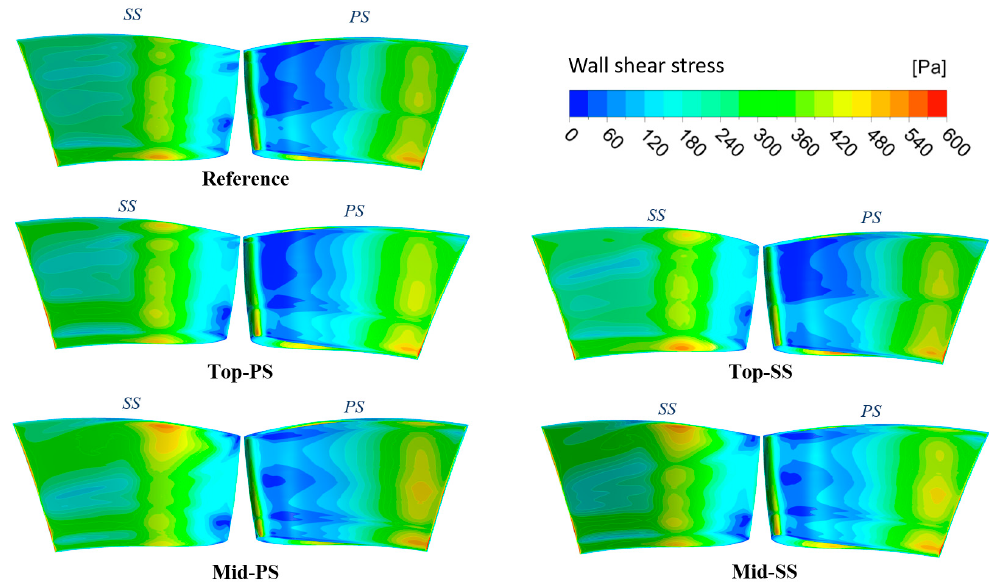
Figure 10. Wall-shear stress distribution on the S2 vane surface under different damaged-blade conditions.